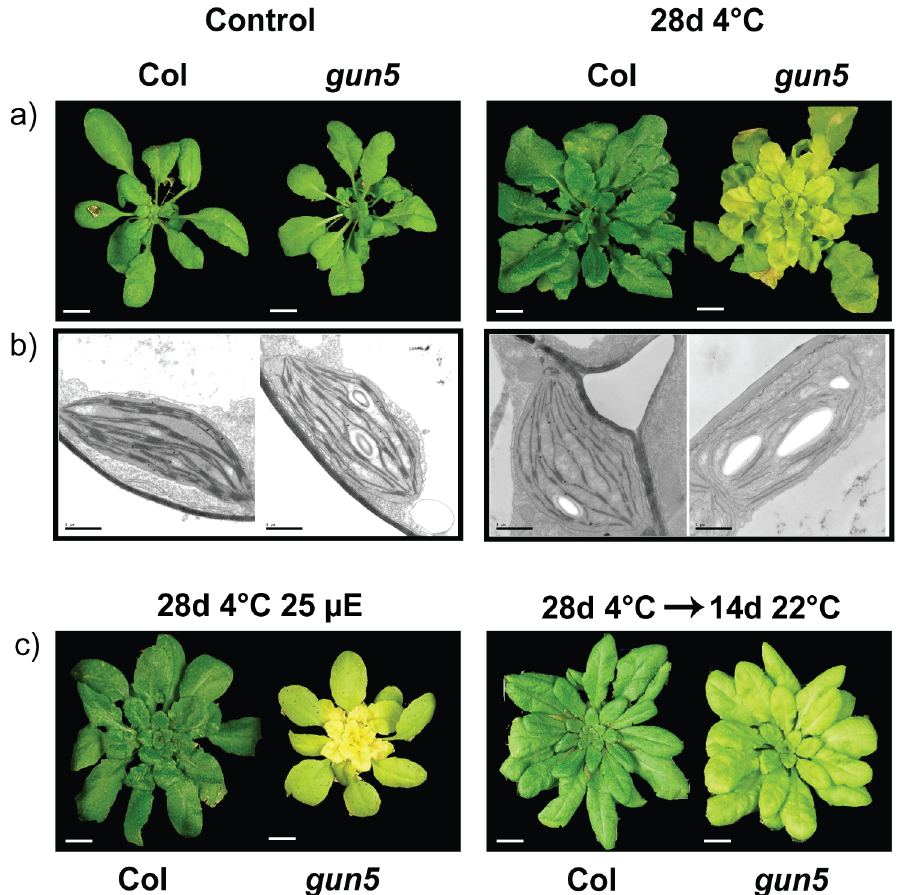
control conditions) were transferred to 4°C, short day condition (9/15 h light/dark, 4°C/4°C, 150 μ E) for 28 days. Bar represents 1 cm. (b) Transmission electron microscopy images of plastids from corresponding plants above. Bar represents 1 μ m. (c) 5 week old plants were grown in SD conditions (150 μ E) and transferred to SD conditions, 4°C (9/15 h light/dark, 4°C/4°C, 25 μ E). After 28 days of cold exposure, plants were transferred back to control conditions for an additional 14 days for